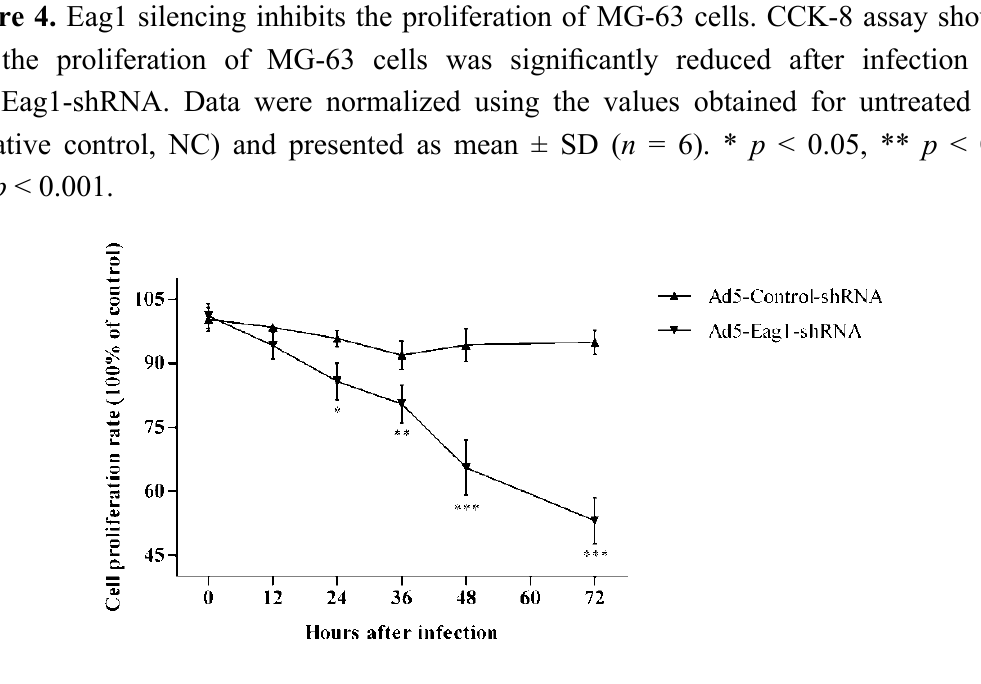
Figure 5. Eag1 silencing inhibits the expression of VEGF and the activation of PI3K and AKT in MG-63 cells. ( A ) Western blot analysis of VEGF levels at different time points following treatment with Ad5-Eag1-shRNA in MG-63 cells. * p < 0.05, ** p < 0.01, *** p < 0.01. n = 3. ( B ) Western blot analysis of p-PI3K, p-AKT, t-PI3K and t-AKT levels in control, Ad5-Control-shRNA and Ad5-Eag1-shRNA group. Grey-value analysis was completed as described above. *** p < 0.001. n =